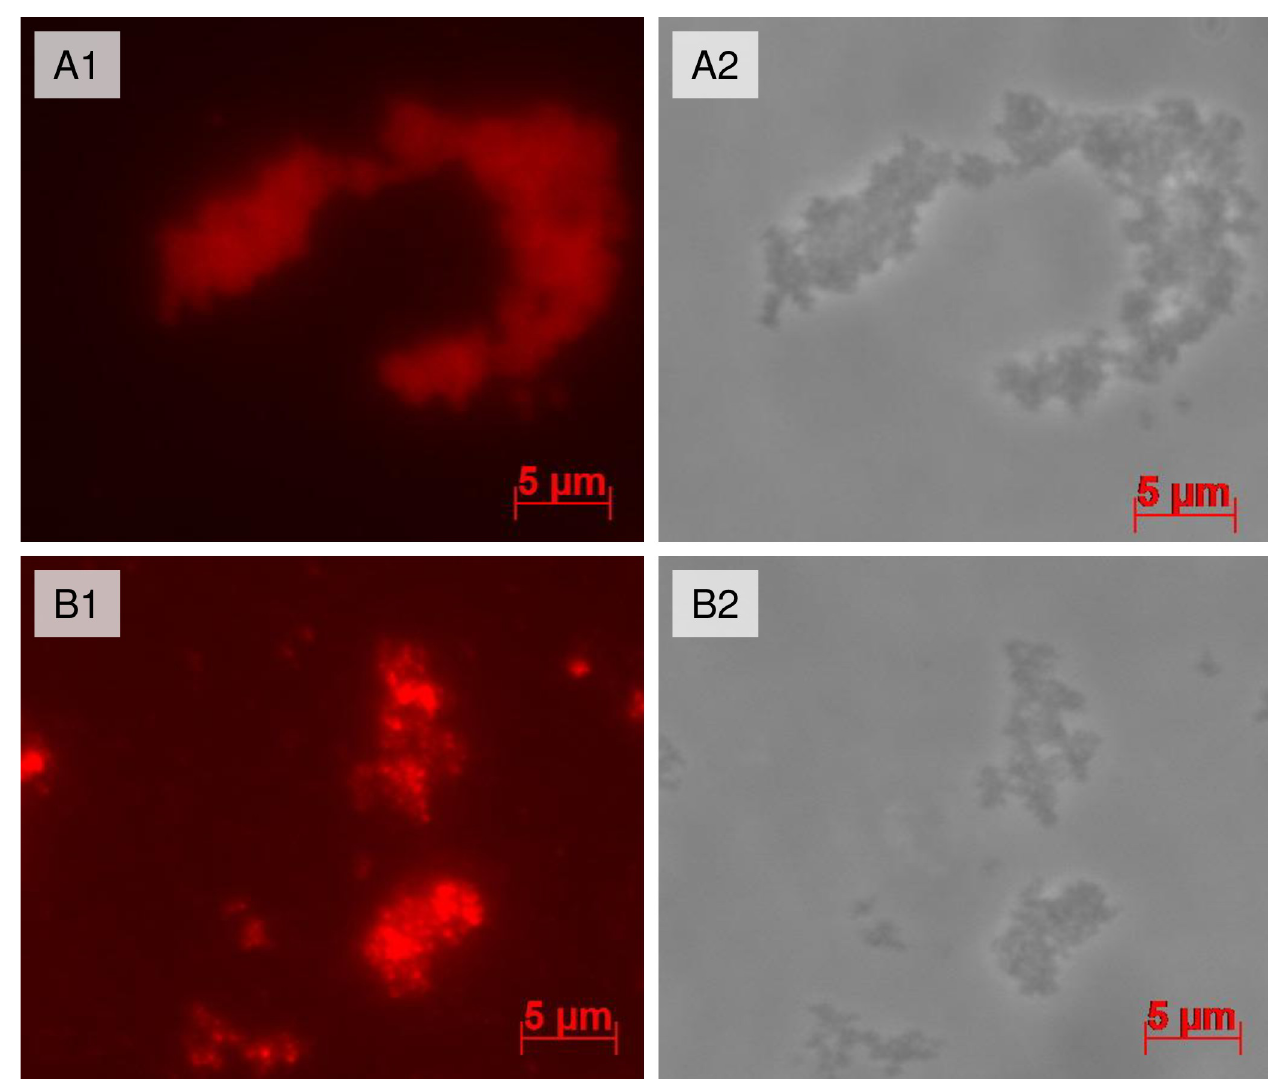
Fig 6. Immunofluorescence microscopy of compositions comprising SP with recombinant protein TM2e adsorbed to their surface. A) Complexes with SP V : 1.–fluorescence image. 2.–the same image in phase contrast. B) Complexes with SP VLP : 1.–fluorescence image. 2.–the same image in phase contrast. Detection with primary antibodies and secondary antibodies conjugated with fluorophore Alexa 546.